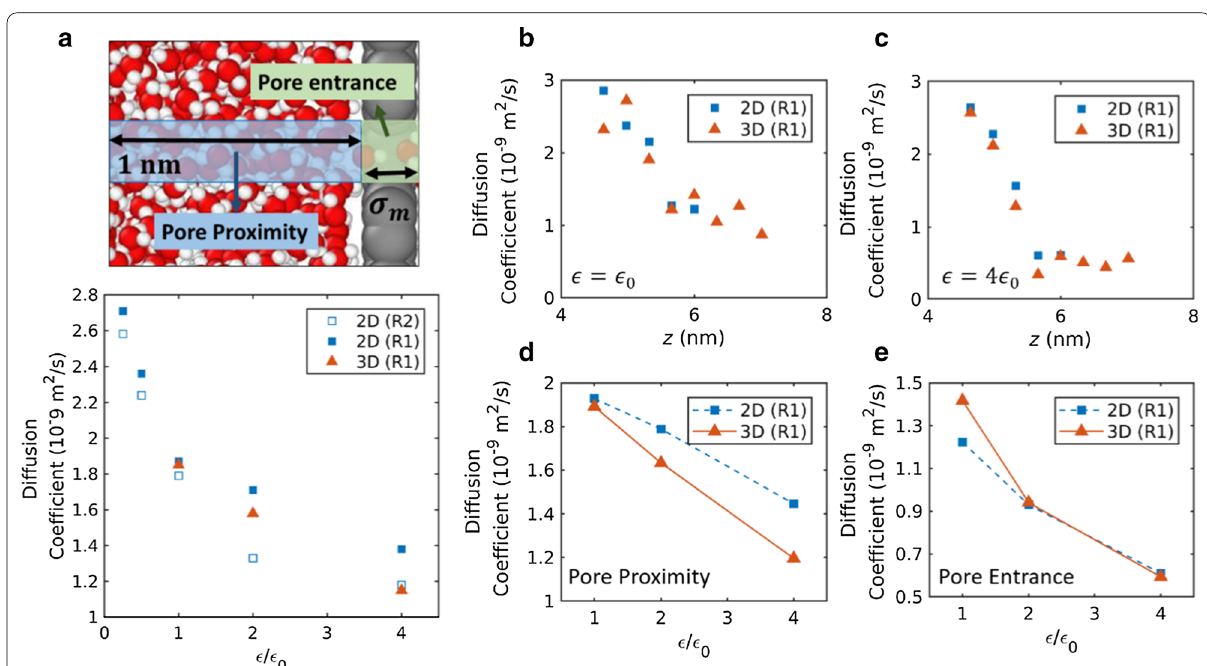
Fig. 5 Water diffusion coefficients in pore proximity and pore entrance region. The pore proximity region is defined as the cylindrical region with a pore radius and 1 nm of length. The pore entrance region is defined as the cylindrical region with a pore radius and van der Waals diameter. a Diffusion coefficient variations with the interaction strength. Diffusion coefficients are measured in areas, including both pore entrance and proximity region. b , c Diffusion coefficient profile along the pore axial direction for an interaction strength of b ǫ 0 and c 4 ǫ 0 . d , e Diffusion coefficient variation with interaction strength in the d pore proximity region and e pore entrance